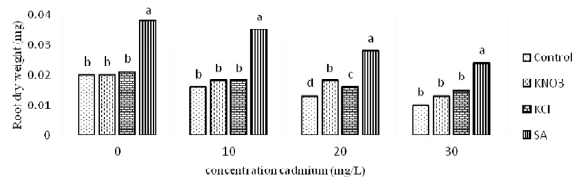
Fig. 6. Root dry weight of unprimed (UPS) and primed (PS) seedling of fenugreek ( Trigonella foenum-graecum L.) under different Cd concentrations Root dry weight was measured in unprimed seeds and when seeds were primed by 100 mg/L SA and -1 MPa KNO 3 and KCl solution for 24 h. The unprimed seeds were used as the control. Means with similar letters were not significant different (p ≤ 0.05) based on LSD test.